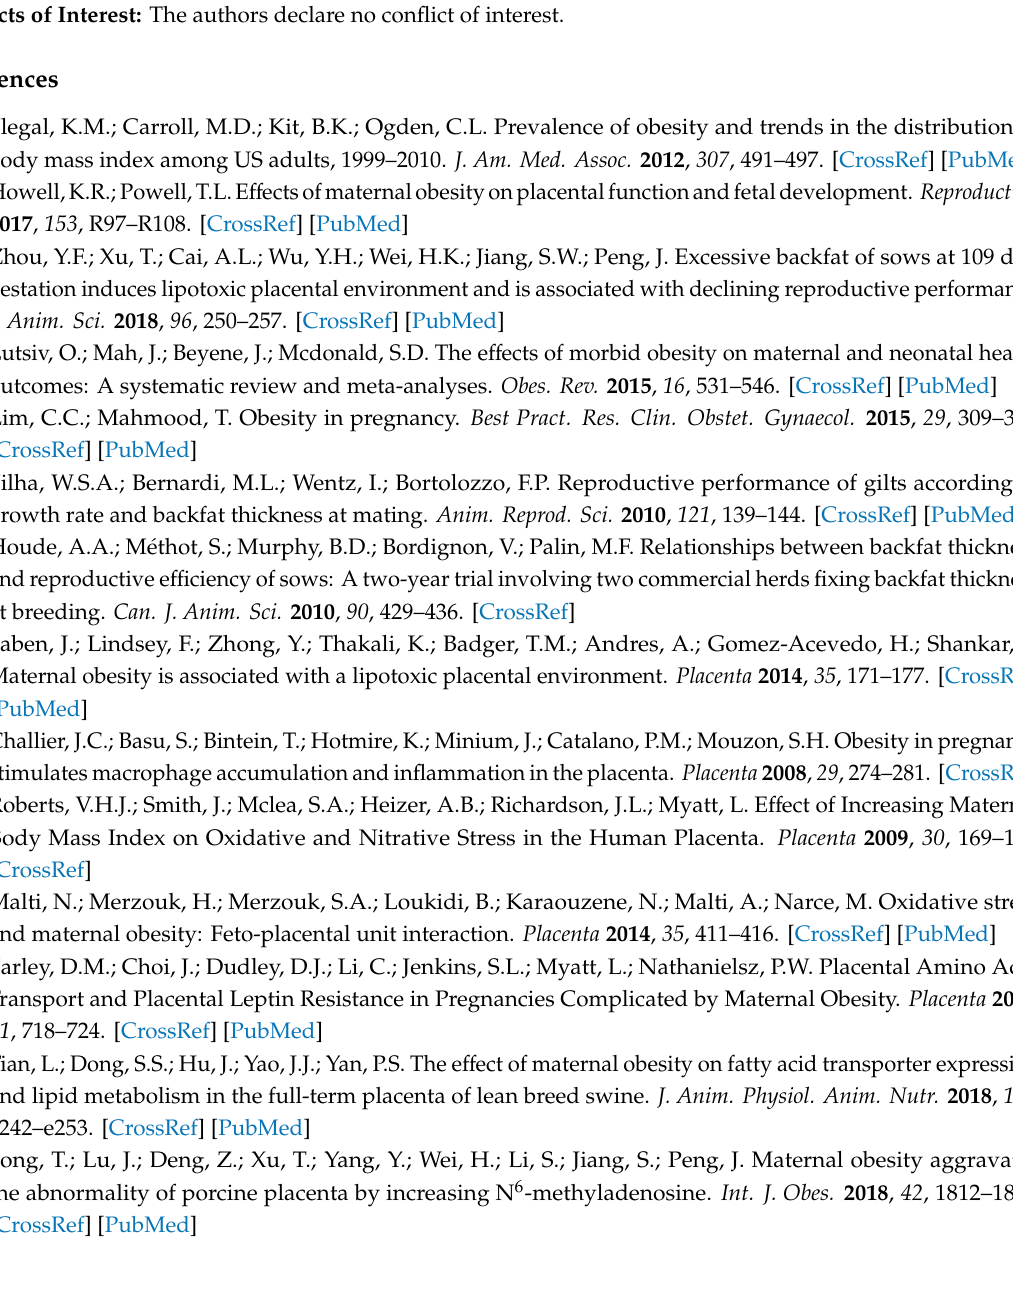
Figure S1: Position for backfat thickness measurement in live pigs (P2; 4–6 cm away from body midline at the last rib level). Figure S2: Flowchart of proteomic experimental design; each pooled biological replicate consists of five male placentas and five female placentas which were randomly selected from ten sows from the same backfat group; the pooled biological samples were labelled with iTRAQ reagents 114, 116, 118, 117, 119 and 121 respectively. Table S1: RT-qPCR primers. Table S2: List of 4652 proteins identified using iTRAQ. Table S3: List of 343 DAPs between the HBF and NBF placentas. Table S4: GO analysis of the DAPs. Table S5: KEGG pathway analysis of the